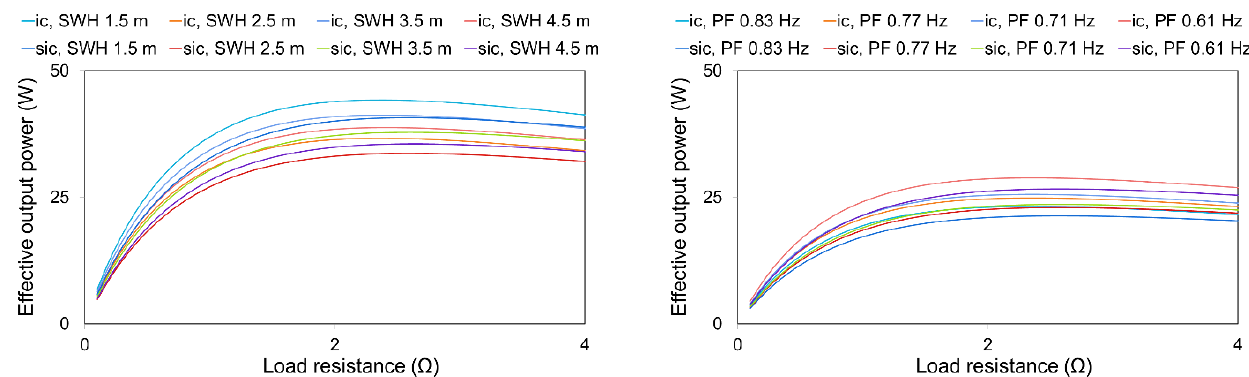
Figure 23. Effective output power resulted from different LPMG designs under different random wave parameters and load resistances (ic: iron-cored, sic: semi iron-cored, SWH: significant wave height, PF: peak frequency).